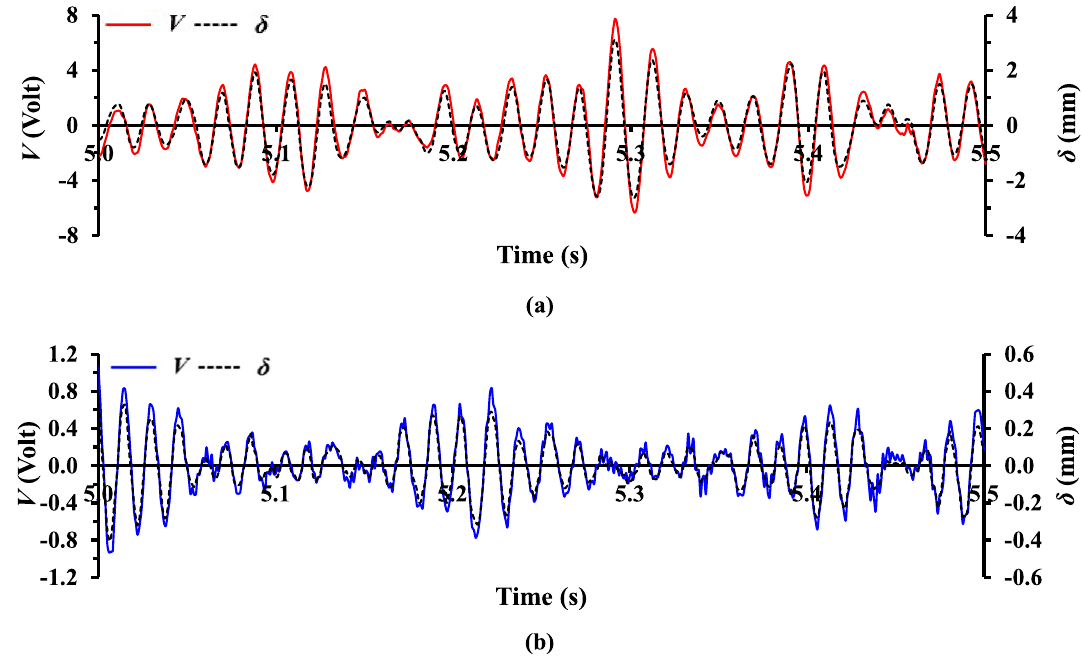
Figure 12. Time series plots of V and δ recorded at x / D h = 0.425 downstream of ( a ) SFG and ( b ) RG